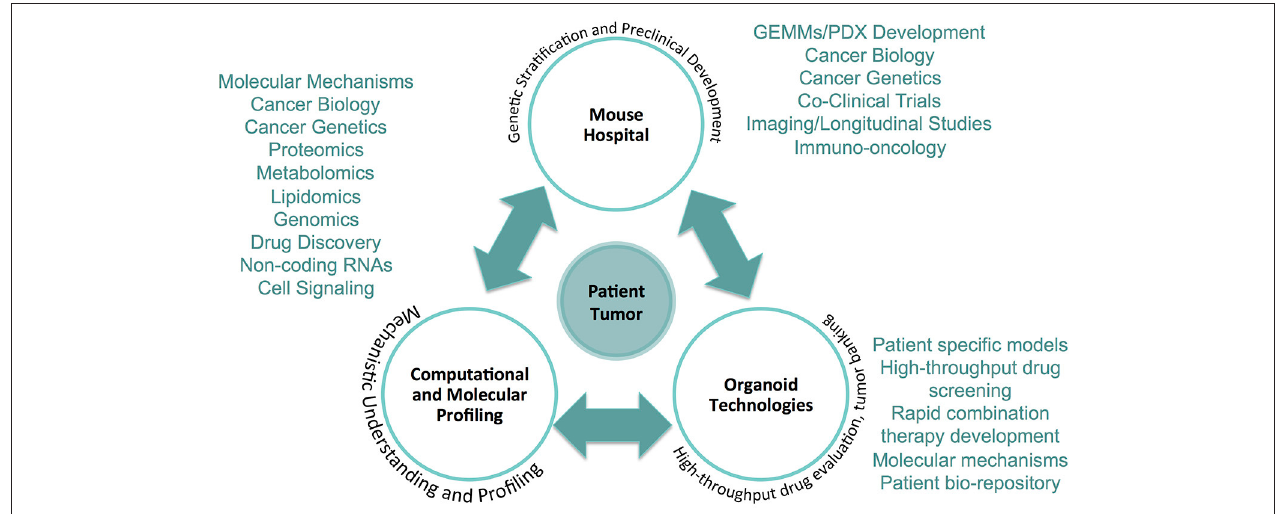
FIGURE 1 | The precision medicine framework integrating The Mouse Hospital. The Mouse Hospital ideally is integrated in an ultra-precision medicine framework whereby data collected from computational and molecular profiling of patient tumors, in addition to screening and characterization of primary cancer organoid cultures, enable prioritization of novel therapeutic strategies for in vivo pre- and co-clinical evaluation. The integration of each of these approaches provides a comprehensive platform that can deliver actionable therapeutic strategies for individual patients that goes above and beyond what is currently available based on targeted genomic